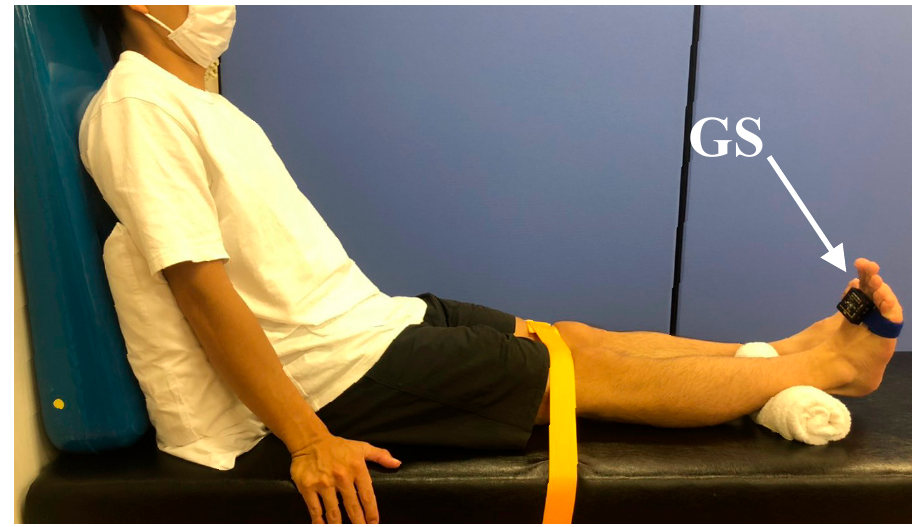
Figure 2. Measurement of ankle plantarflexion angular velocity. Participants sat on a bed with their backs against the backrest. The backrest tilted backward by 30°. The gyroscope (GS) was attached to the dorsum of the feet.